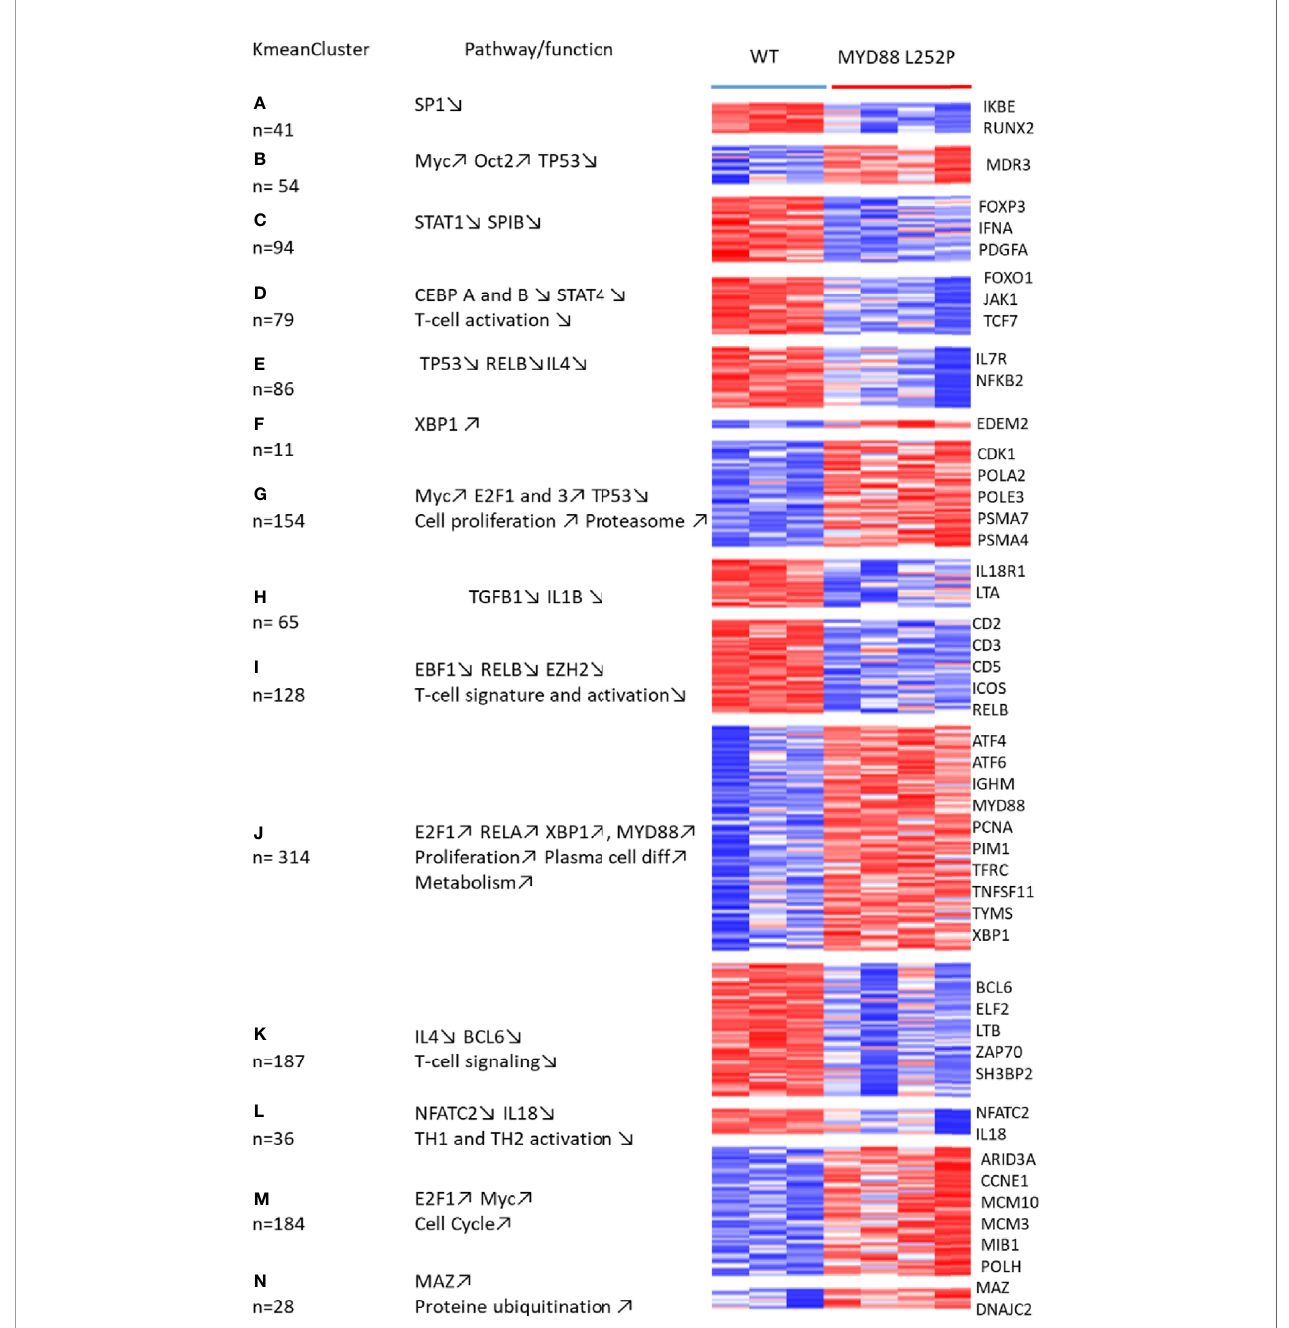
FIGURE 9 | Whole transcriptome analysis of Cd19 Cre and Myd88 L252P mice: total mRNA was extracted from whole spleen tissues. Gene expression pro fi les were obtained using the MoGene-2_1-st-v1 Affymetrix chip. mRNA transcripts (3236) were selected to be differentially expressed using the Limma R package. Expressed genes that were too heterogeneous were eliminated, resulting in a fi nal selection of 1515 genes. These genes were segregated into 40 Kmean clusters. The closest Kmean clusters were merged 2 by 2 according to their proximity by principal component analysis of the mean vectors. This was repeated until maximization of the absolute value of Chi2 (29). This resulted in 14 aggregated clusters. Functional annotation of the aggregated Kmean clusters was performed using the Ingenuity Pathway Analysis (IPA) Software. Annotated heatmap of the 1515 genes are segregated into the 14 aggregated clusters. Left: the aggregated Kmean clusters with the corresponding number of genes; middle: main pathways and or function identi fi ed with the IPA software; right: some relevant